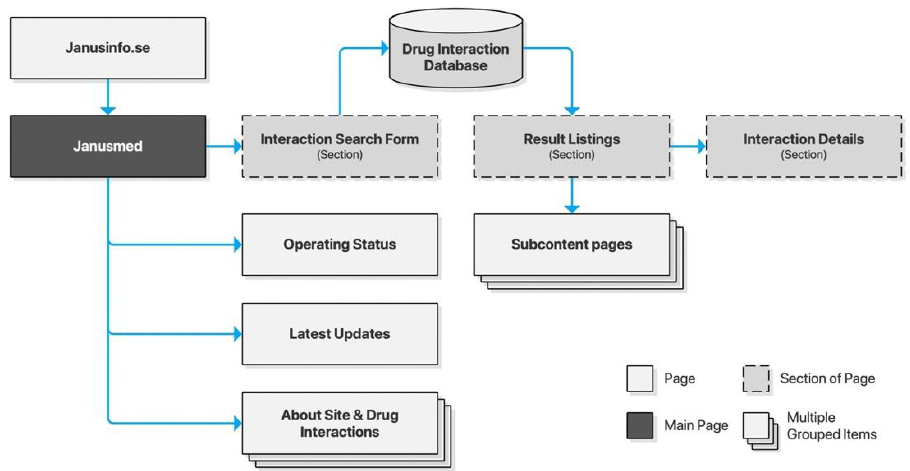
Figure 2. Sitemap for Janusinfo.se.